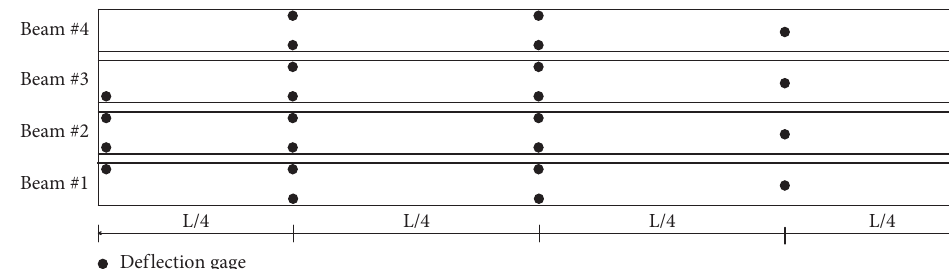
Figure 8: Layout of the deflection gages in Loading Cases 1 and 2.